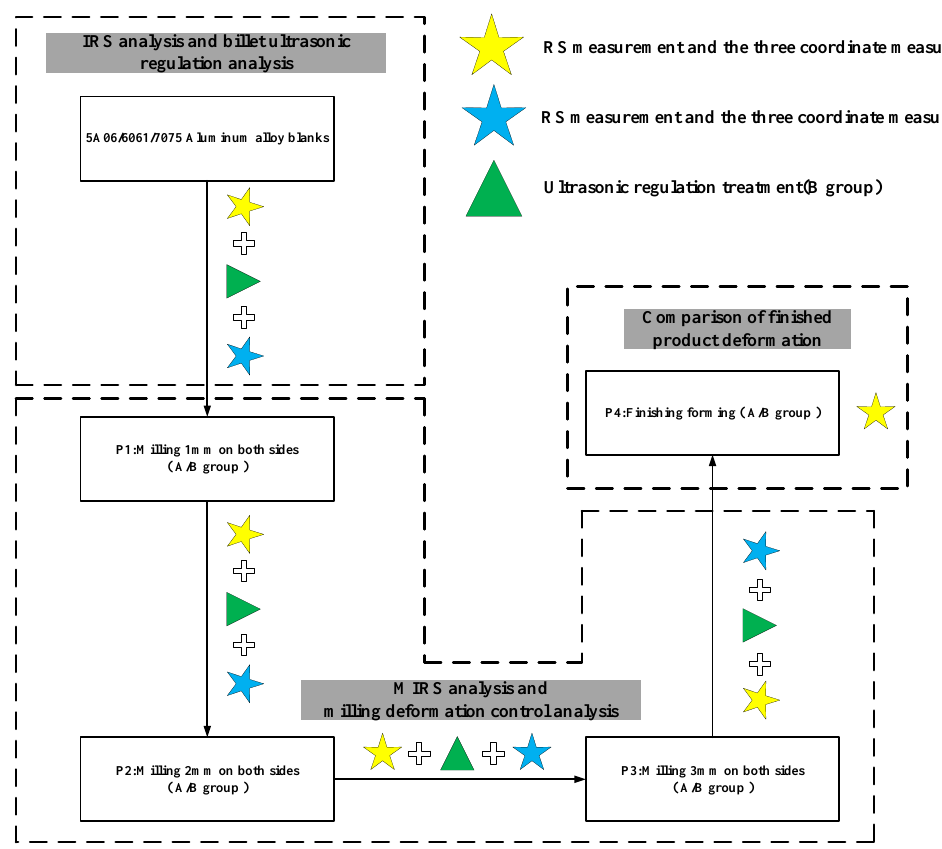
Figure 3. Test process diagram.